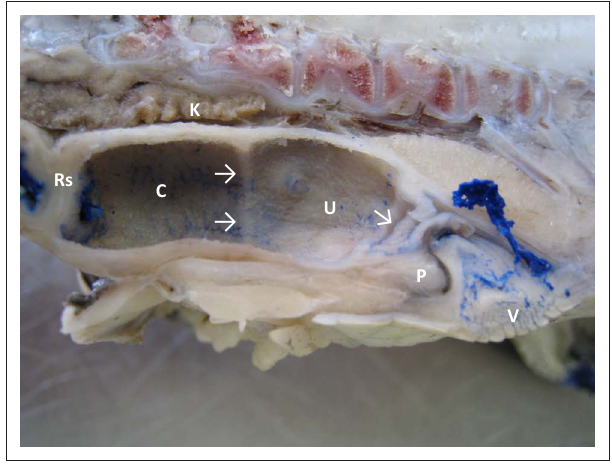
Source : Photograph by Fritz Huchzermeyer Note the uroproctodeal sphincter (single white arrow), the poorly developed coprourodeal fold (double white arrows) and the well-developed rectocoprodeal sphincter. Blue latex was injected into the cloaca in situ , remnants of which are still visible, particularly in the proctodeum. Rs, rectocoprodeal sphincter; C, coprodeum; K, kidney; U, urodeum; P, proctodeum; V, vent. FIGURE 1: A midline section through the cloaca of a juvenile Nile crocodile, illustrating the relative positions of the vent, proctodeum housing the phallus, urodeum and